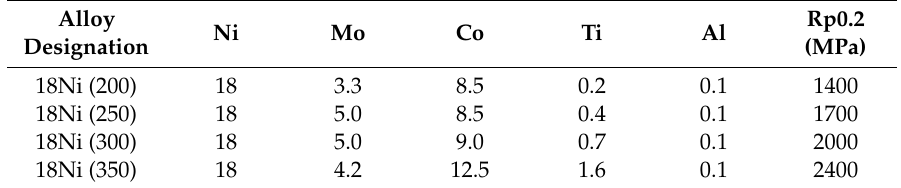
Table 1. Chemical composition (wt%) and strength of commercial-grade maraging steels, Inco [24]. Alloy Ni Designation